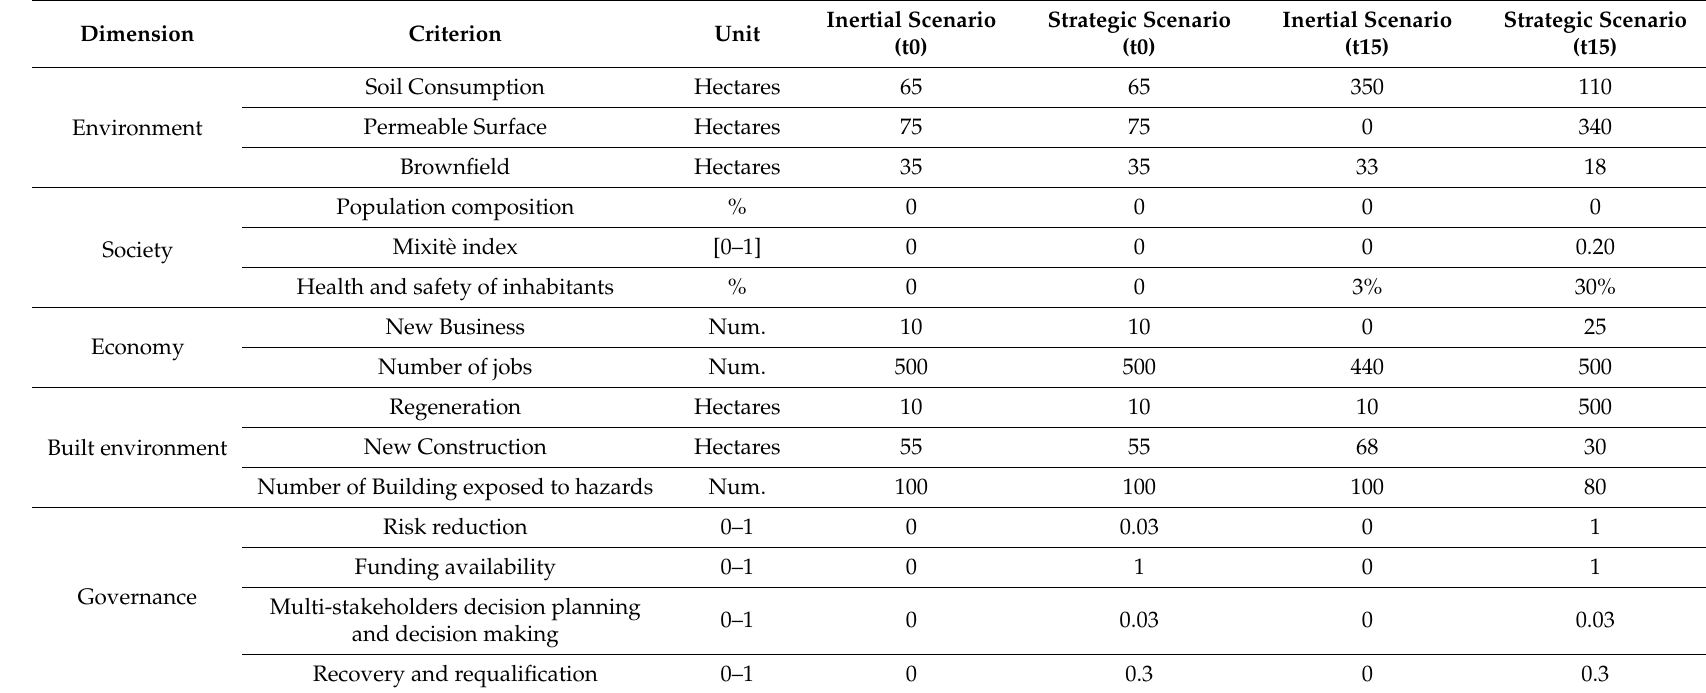
Table A1. Performance matrix for Inertial Scenario and Strategic Scenario, at time t0 and